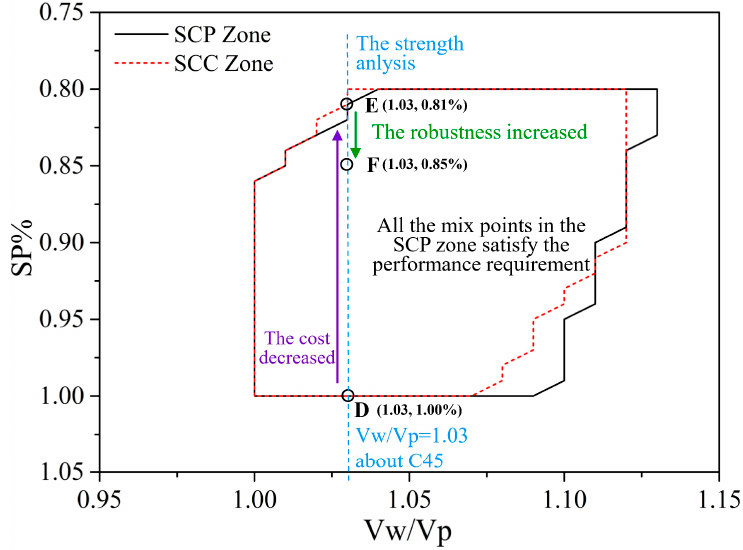
Figure 14. The strength-based mix design of series 3.